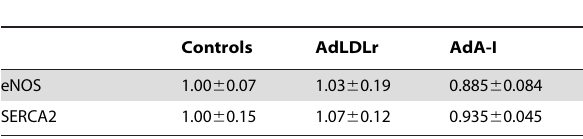
Table 4. Analysis of mRNA expression levels of eNOS and SERCA2 in the left ventricular myocardium 6 weeks after gene transfer or saline